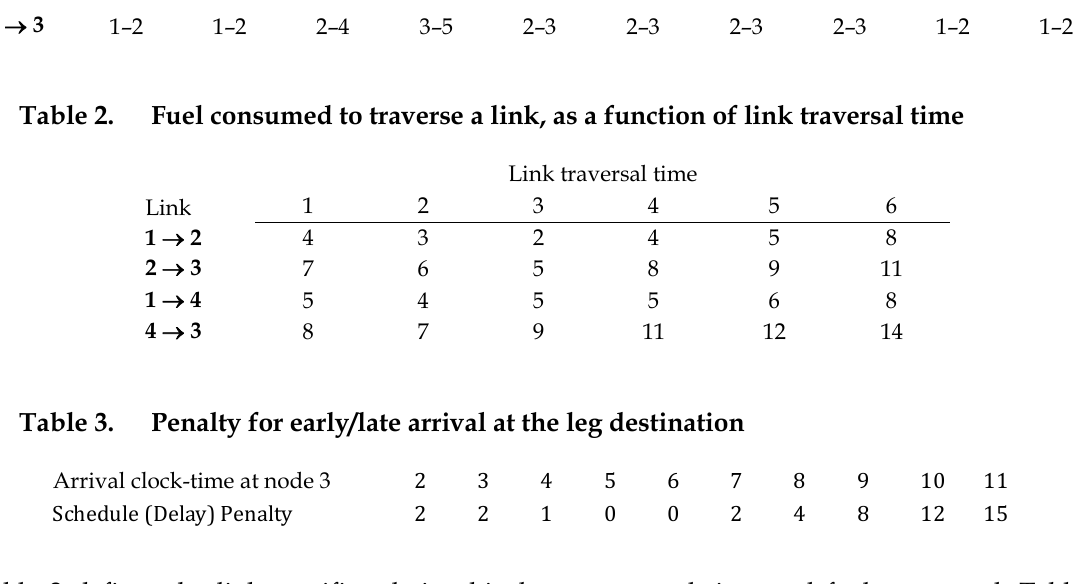
Table 2 defines the link-specific relationship between travel time and fuel consumed. Table 3 reflects any penalties for arriving outside a preferred arrival time window at the destination.